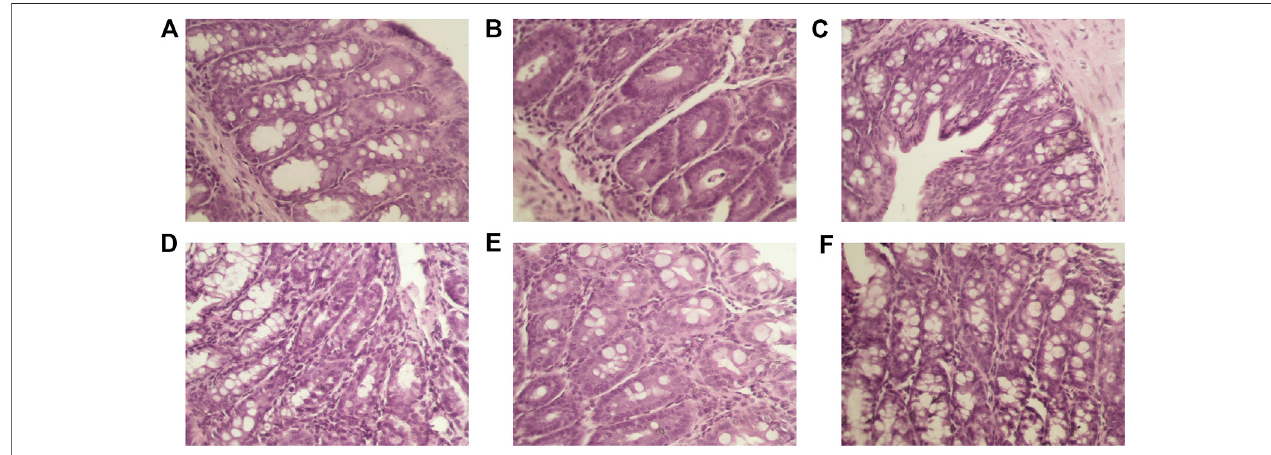
FIGURE 7 | Effects of lavender essential oil on colonic pathological damage ( ×